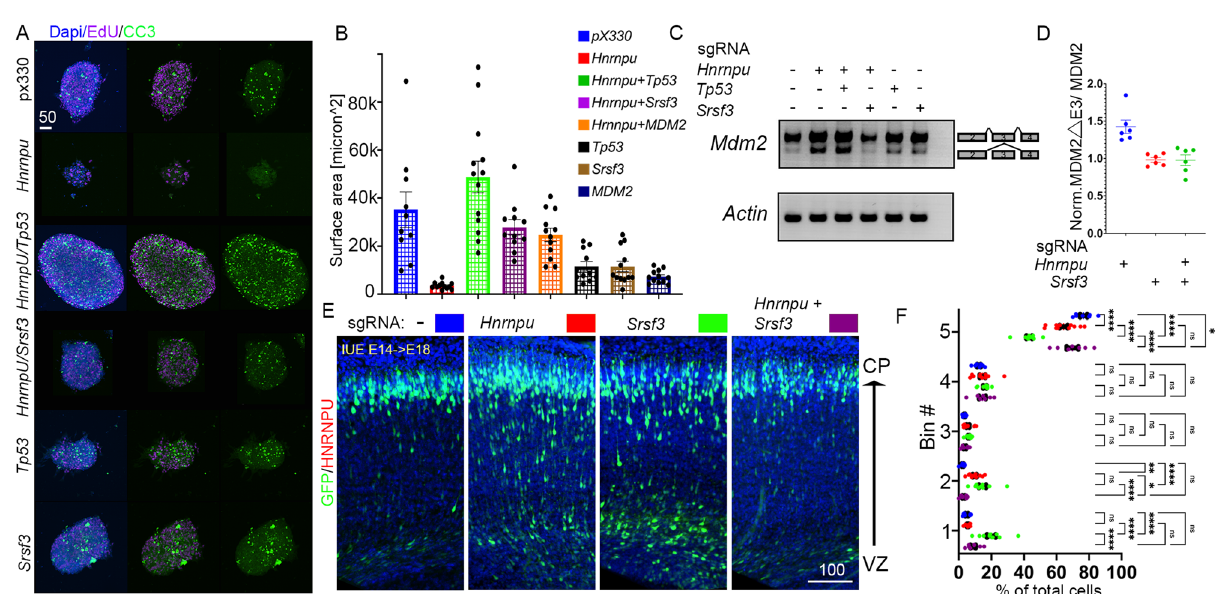
Fig. 6 Srsf3 downregulation compensates for HNRNPU loss of activity. A Images of E14 derived mouse cortex neurospheres electroporated with either px330 (CRISPR/CAS9 Control plasmid) or with two sgRNA sequences, for either Hnrnpu , Tp53 , or Srsf3 . When genes are targeted ( Hnrnpu and Tp53 or Hrnrnpu and Srsf3 ), neurospheres grow to large sizes (DAPI, Blue) and incorporate EdU (Magenta) despite the accumulation of activated Caspase 3 (CC3, green). B Quanti fi cation of the size of neurospheres, two days post electroporation treated with the indicated combination of CRISPR/CAS9 sgRNA ’ s or overexpressing MDM2. Px330, n = 10 Hnrnpu sgRNA n = 12 Hnrnpu + Tp53 sgRNA n = 13 Hnrnpu + srsf3 sgRNA n = 11 Hnrnpu sgRNA + MDM2 n = 12 Tp53 sgRNA n = 11 Srsf3 sgRNA n = 12 MDM2 n = 12. Error bars ±SE. Analysis was done using ordinary one-way ANOVA with Dunnett ’ s multiple comparisons test. C Splice variants sensitive PCR of cDNA prepared from treated neurospheres (depicted in panels A and B) shows correction of the over- representation of MDM2 Exon 3 skipping splice variant (300 bp vs. 250 pb, actin band size: 150 bp). One-way ANOVA with Dunnett ’ s multiple comparison test. Adjusted p values vs. control: Hnrnpu < 0.0001, Hnrnpu + Tp53 , Hnrnpu + Srsf3 NS, Hnnrpu + MDM2 NS, Tp53 p = 0.0007, Srsf3 p = 0.0005, MDM2 p < 0.0001. Error bars (±SEM). D qPCR of the relative abundance of MDM2 isoforms in cultured Neurospheres (NS). Graphs depicted transcript levels, compared to control (p x 330, no sgRNA) of MDM2 splice variants (MDM2 lacking exon 3 (MDM2 Δ E3)/MDM2 with retained E3 (MDM2) in NS treated with the indicated combination of CRISPR/CAS9 sgRNA ’ s, n = 6. Error bars (±SEM) are indicated. Coronal sections (60 μ M) shows the location of radially migrating cortical neurons electroporated with the control plasmid (blue), Hnrnpu sgRNA (red), Srsf3 sgRNA (green), both genes (purple). E , F Distribution GFP + cells (%) in fi ve horizontal bins across the cortex width (1 the most apical), Averages, and error bars (±SEM). VZ-Ventricular Zone, CP-cortical plate. Three biological repeats were used; 2 – 4 70 μ M thick slices of comparable position were analyzed of each electroporated brain. Control n = 8, Hnrnpu sgRNA n = 11, Srsf3 sgRNA n = 9, Srsf3 + Hnrnpu sgRNA n = 7. Analysis was done using two-way ANOVA with Tukey ’ s multiple comparisons test. P values: ** p < 0.01, *** p < 0.001, **** p < 0.0001, ns non signi fi cant. Source data are provided as a Source Data fi